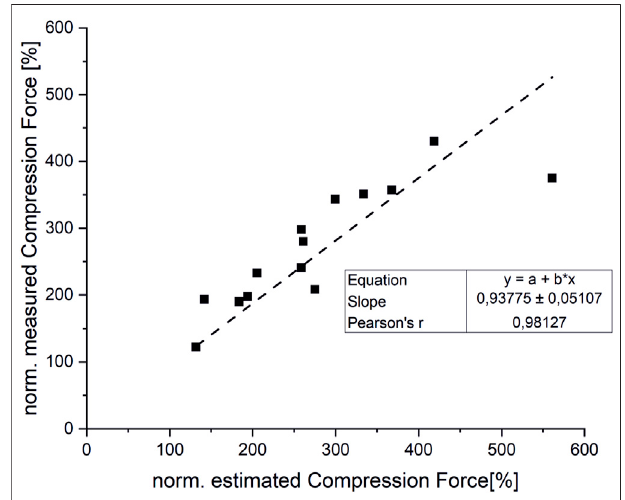
FIGURE 9| Correlation between measured and estimated compression forces (normalized to upright